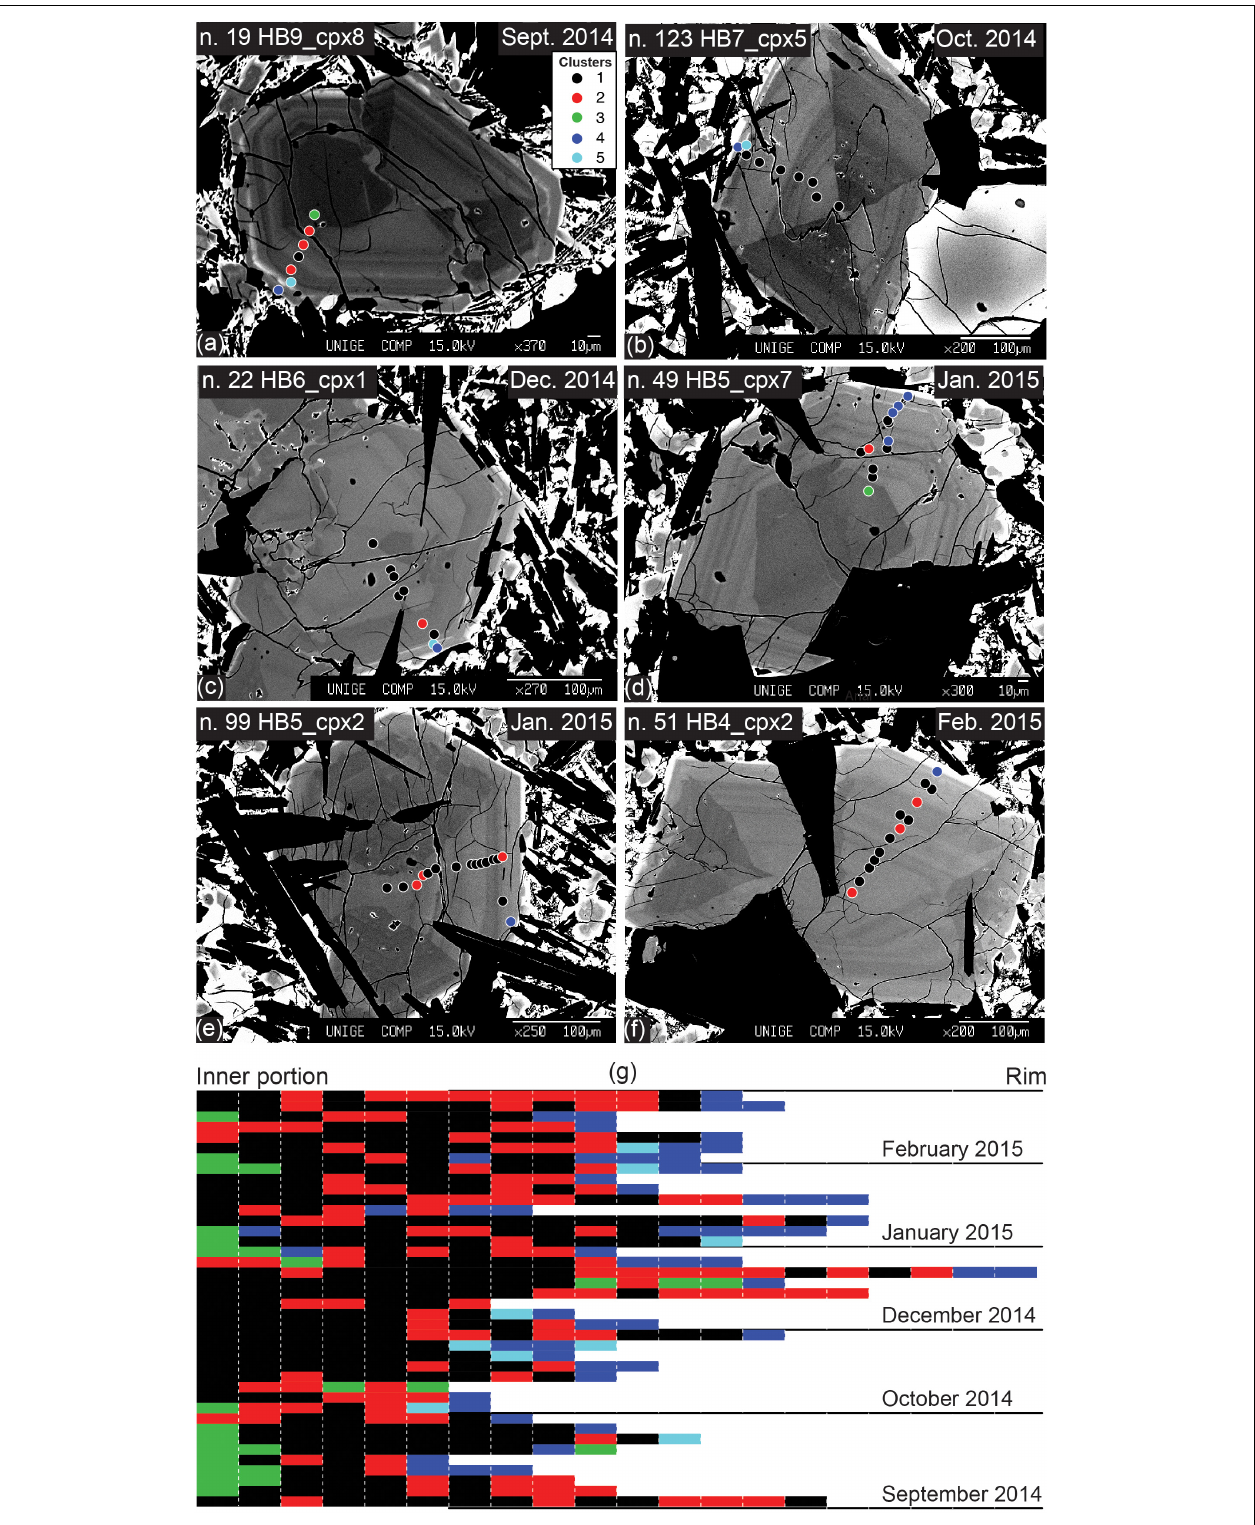
FIGURE 6 | SEM Backscattered images of selected clinopyroxene crystals with location of major and trace element analyses. (a–f) The circles show the location of the EPMA spots with a color corresponding to the associated cluster assignment. (g) Each of the horizontal segments represent a spot and the color refers to the cluster to which each spot was assigned by